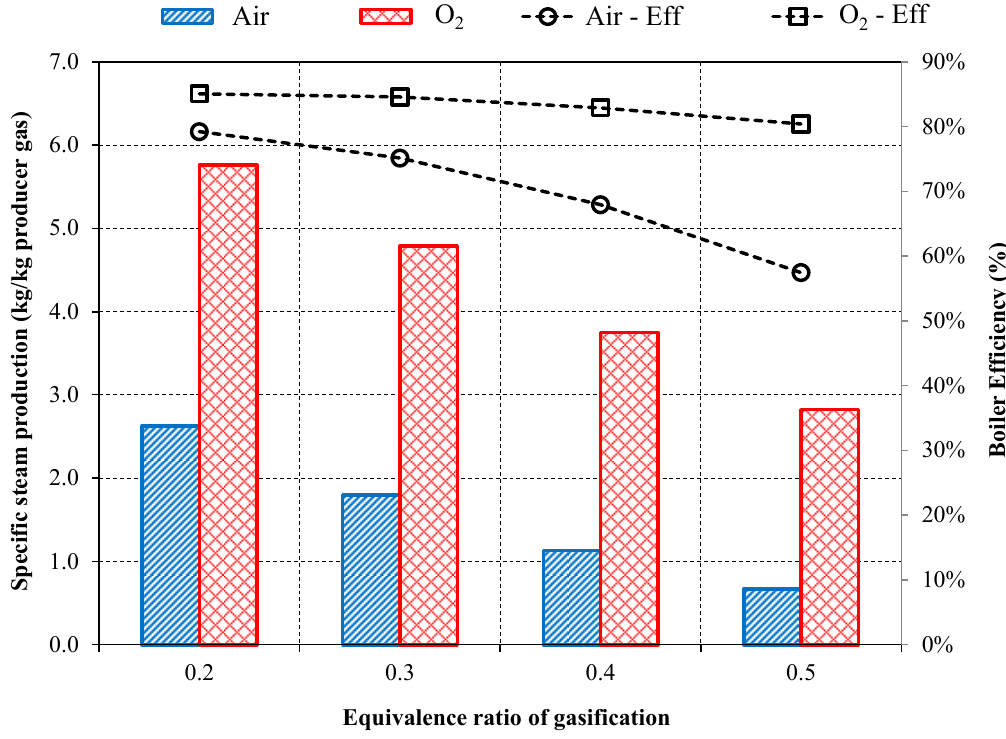
Figure 11. Energy performance indicators of Rankine cycle boiler.